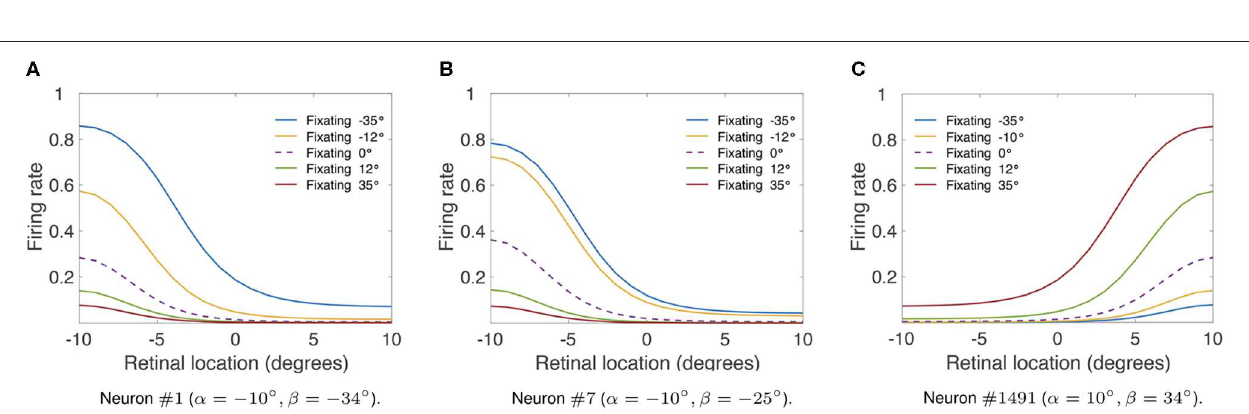
FIGURE 4 | Modulation of visual neuron responses by eye position in the hardwired model. The figure shows the gain modulation by eye position of visual responses of neurons in the hardwired model. (A) Shows the visual responses of neuron # 1 ( α = − 10 ◦ , β = − 34 ◦ ), (B) shows the visual responses of neuron # 7 ( α = − 10 ◦ , β = − 25 ◦ ) and (C) shows the visual responses of neuron # 1491 ( α = 10 ◦ , β = 34 ◦ ).The x-axis (abscissa) indicates the retinal location of the visual stimulus. Table 1 gives the simulation parameters for the model. Each curve corresponds to fixations with the following eye positions: − 35 ◦ , − 12 ◦ ,0 ◦ ,12 ◦ and 35 ◦ . The broken line represents fixation straight ahead (i.e., 0 ◦ ). The symbols were obtained by multiplying the straight-ahead fixation response curve by a different constant value for each of the other response curves. The response curves in each subplot show that there is a form of modulation of the visual responses by eye position that is approximately multiplicative over the simulated retinal locations of the stimulus with a sigmoidal transfer function (Equation 7).